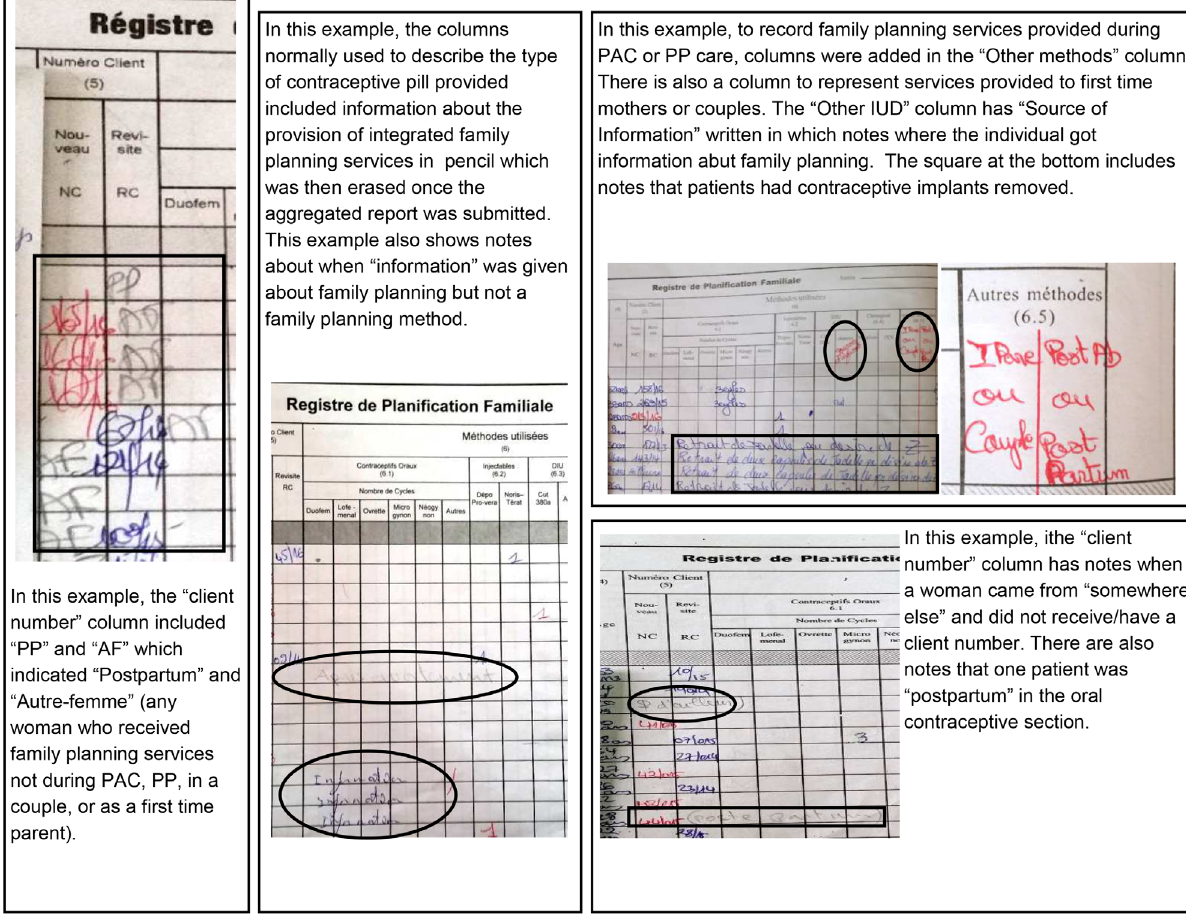
Figure 3. Ways of adapting the family planning register to record integrated services. How health workers adapted registers to capture necessary family planning services information necessary to report to the Togolese Ministry of Health and NGOs.